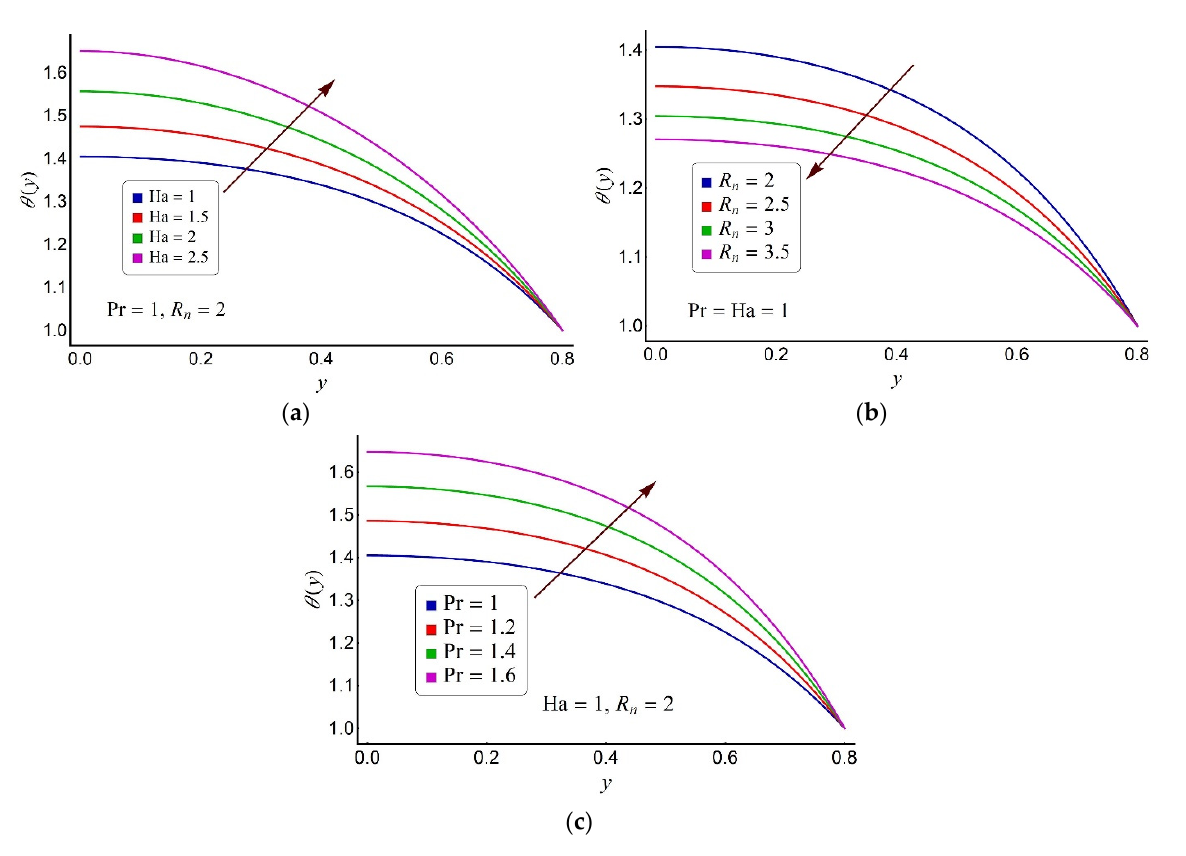
Figure 5. Alterations in temperature profile for various values of ( a ) the Hartmann number (Ha), ( b ) the thermal radiation number ( R n ), and ( c ) the Prandtl number (Pr).